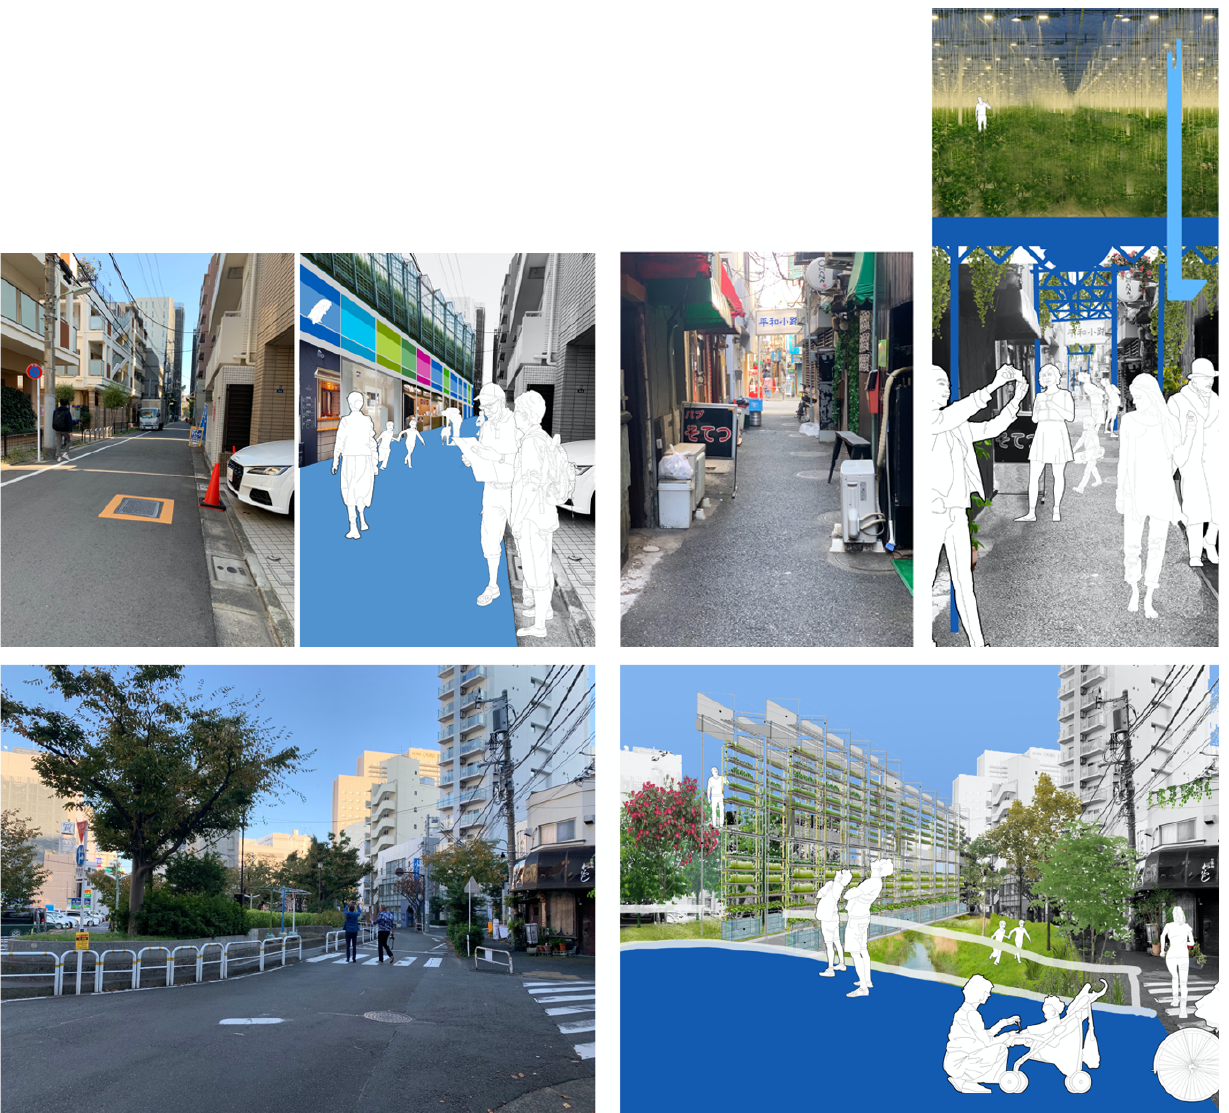
Figure 14. Design propositions for local public spaces. Source: Courtesy of Bill